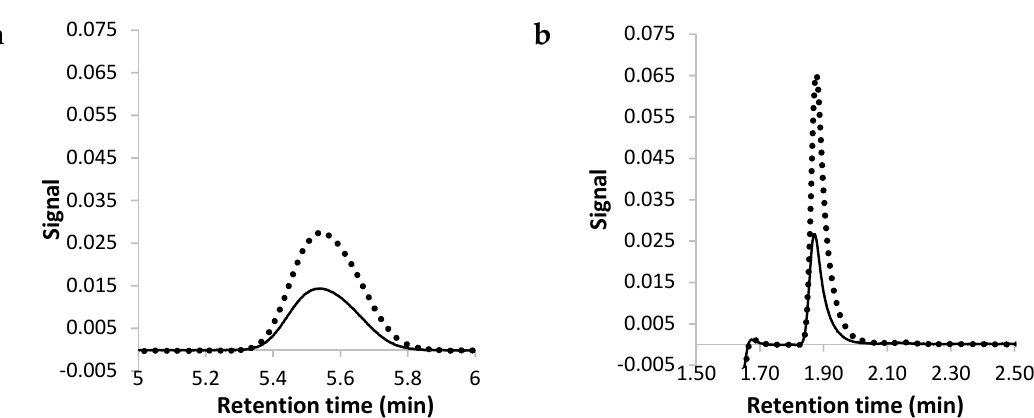
Figure 1. The chromatograms for 1 µg/mL (dotted line) and 0.5 µg/mL (solid line) melatonin using mobile phase containing ( a ) methanol 40%, ( b ) methanol 75%.